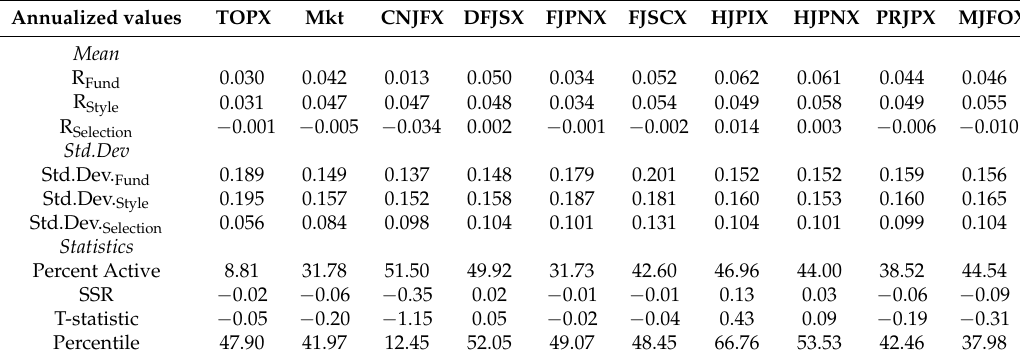
Table 8. Fund returns based on style and asset selection (April 2005–March